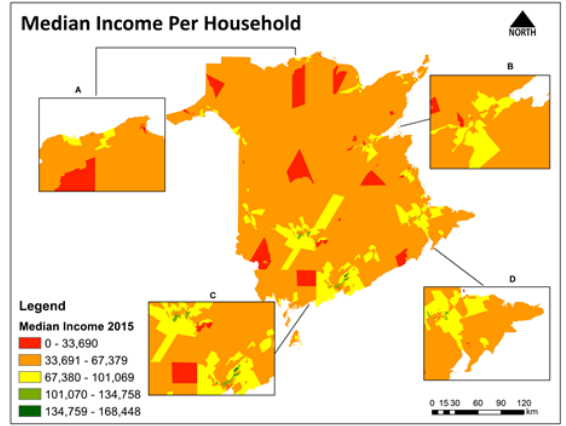
Figure A12. Total Median Income Per Household.